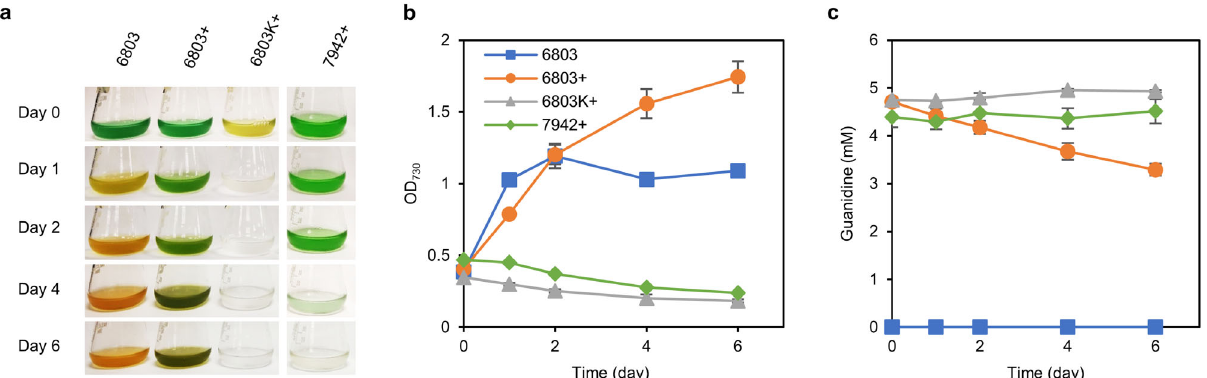
Fig. 1 Varied capabilities in degrading guanidine between two model cyanobacterial species. a Phenotypes of Synechocystis 6803 and Synechococcus 7942 grown in nitrate-deprived medium with or without guanidine. 6803, Synechocystis 6803 strain grown in the nitrate-deprived medium; 6803 + , Synechocystis 6803 strain grown in nitrate-deprived medium supplemented with 5 mM guanidine. 6803 K + , Synechocystis 6803 cells initially killed by heating at 95 °C for 10 min and then resuspended in the nitrate-deprived medium supplemented with 5 mM guanidine. 7942 + , Synechococcus 7942 strain grown in nitrate-deprived medium supplemented with 5 mM guanidine. b Time courses of cell mass accumulation as monitored by absorbance at 730 nm (OD 730 ). c Time courses of guanidine concentrations in the culture supernatants. Data represent means and standard deviations from three biological replicates. Source data underlying panels ( b , c ) are provided as a Source Data fi